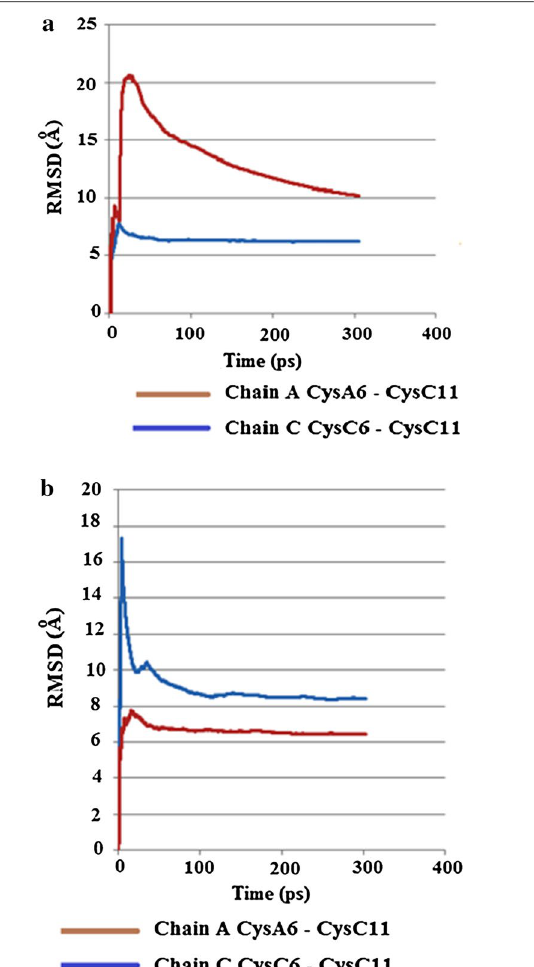
Fig. 22 a Plot of RMSD kinetics of Cys6–Cys11 torsion angles χ3 for the HR insulin, Insugen (I) MD simulations carried out on the major conformation of chain C Cys6–Cys11 at 310 K. b Plot of RMSD kinetics of Cys6–Cys11 torsion angles χ3 for the HR insulin Insugen (I) MD simulations carried out on the major conformation of chain C Cys6– Cys11 at 320